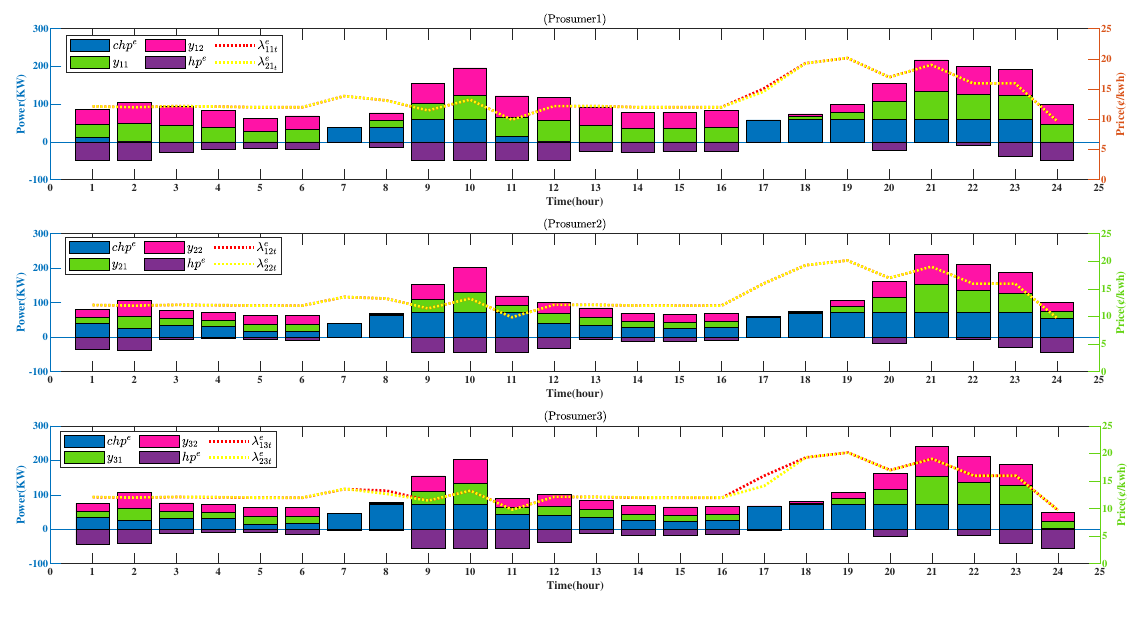
Figure 8. The electrical power balance of prosumers along with electricity price variations. Figure 9 exhibits the thermal load supply of each prosumer and the gas price bid of each retailer. At hours with high electricity prices, the prosumers use CHP and boiler units to supply heat power. For instance, prosumer 1 uses a combination of boilers, heat pumps, and CHP units for power supply at 7:00–11:00 and 17:00–23:00 and utilizes the heat pump at off-peak hours, including 1:00–6:00, when the electricity price is